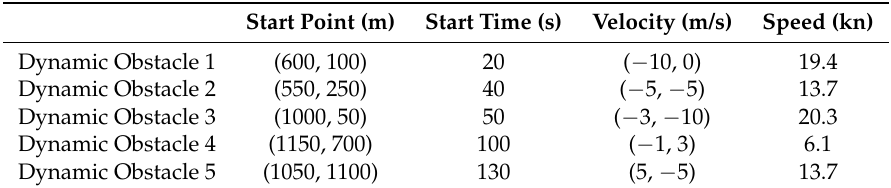
Table 4. The information of dynamic obstacles.